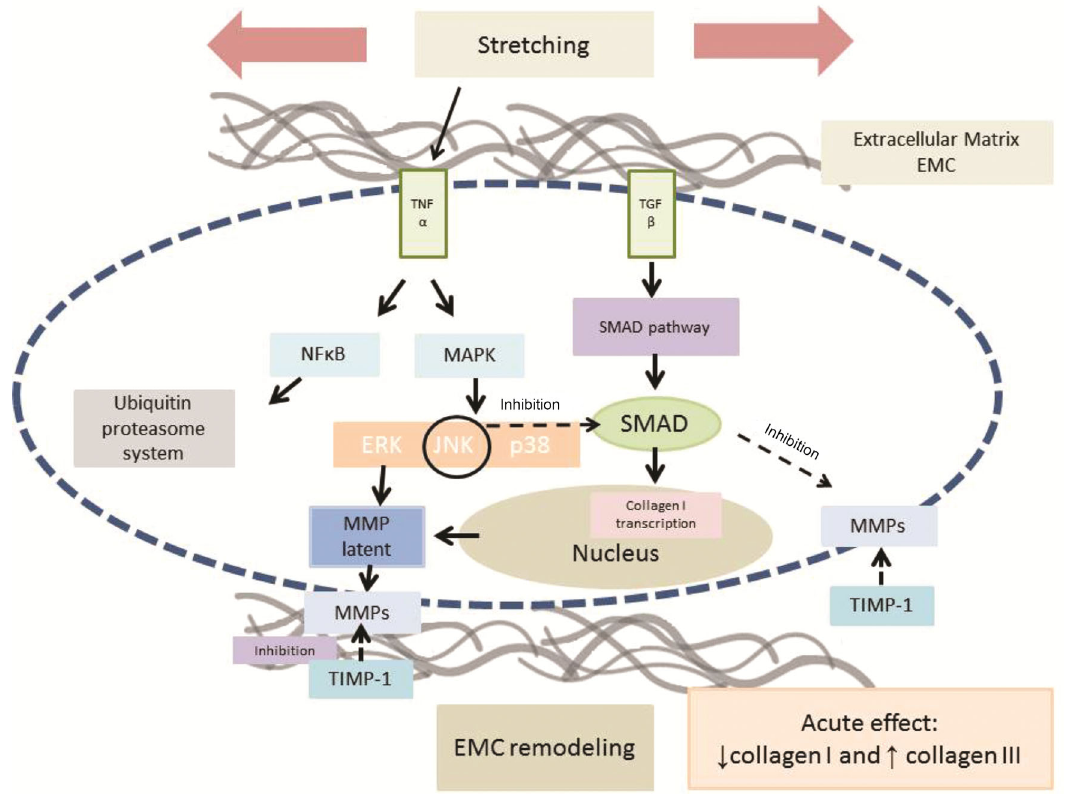
Figure 2 - Probable signaling pathways involved in the acute response to skeletal muscle stretching exercises. Stretching stimulus increases TNF- a immunostaining in soleus muscle, and TNF- a might activate the MAPK and NF k B pathways. The MAPK pathway can inhibit SMAD phosphorylation via TGF- b , inhibiting collagen type I immunostaining. Furthermore, TNF- a can inhibit the TGF- b receptor and hence, the TGF- b /SMAD pathway. In addition, MAPK may activate the metalloproteinases which are regulated by their inhibitors (TIMPs). TNF- a can also signal the NF k B pathways that might activate proteolysis through the ubiquitin-proteasome system. The blue dashed line represents sarcolemma. Gray lines represent extracellular matrix. Arrows: activation. Dashed arrows: inhibition. TNF- a : tumor necrosis factor-alpha. TGF- b : transforming growth factor-beta. NFkb: nuclear factor kappa B. MAPK: mitogen-activated protein kinase. SMAD: intracellular proteins that transduce extracellular signals from transforming growth factor beta ligands to the nucleus where they activate downstream gene transcription. ERK: extracellular signal-regulated kinases. JNK: Jun kinase. p38: p38 mitogen- activated protein kinase. MMP: matrix metalloproteinases. TIMP: Tissue inhibitors of metalloproteinases. EMC: extracellular